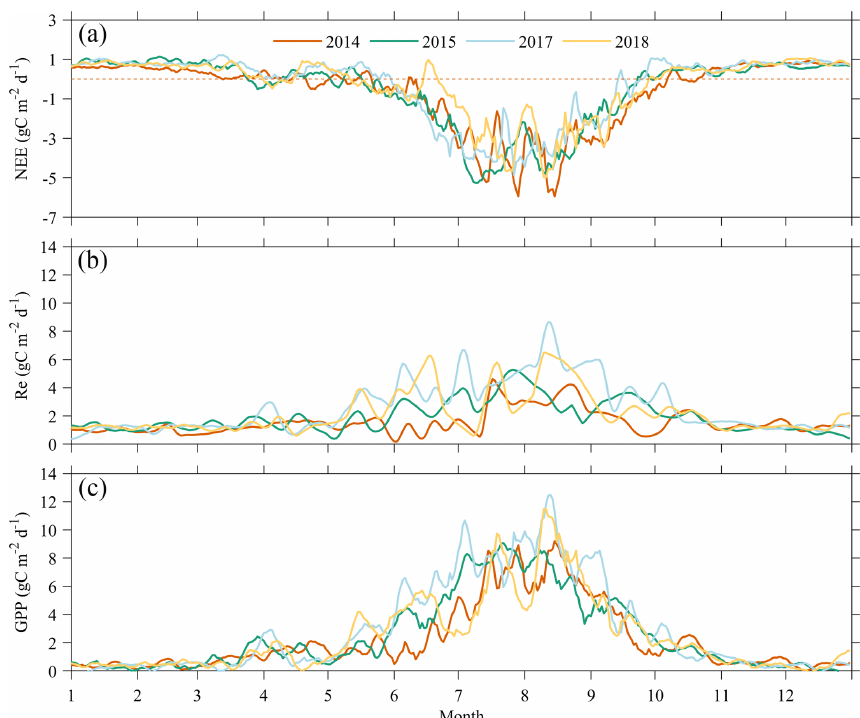
Figure 4. Seasonal variability of daily 5d moving average daily NEE, Re, and GPP in the swamp alpine meadow.